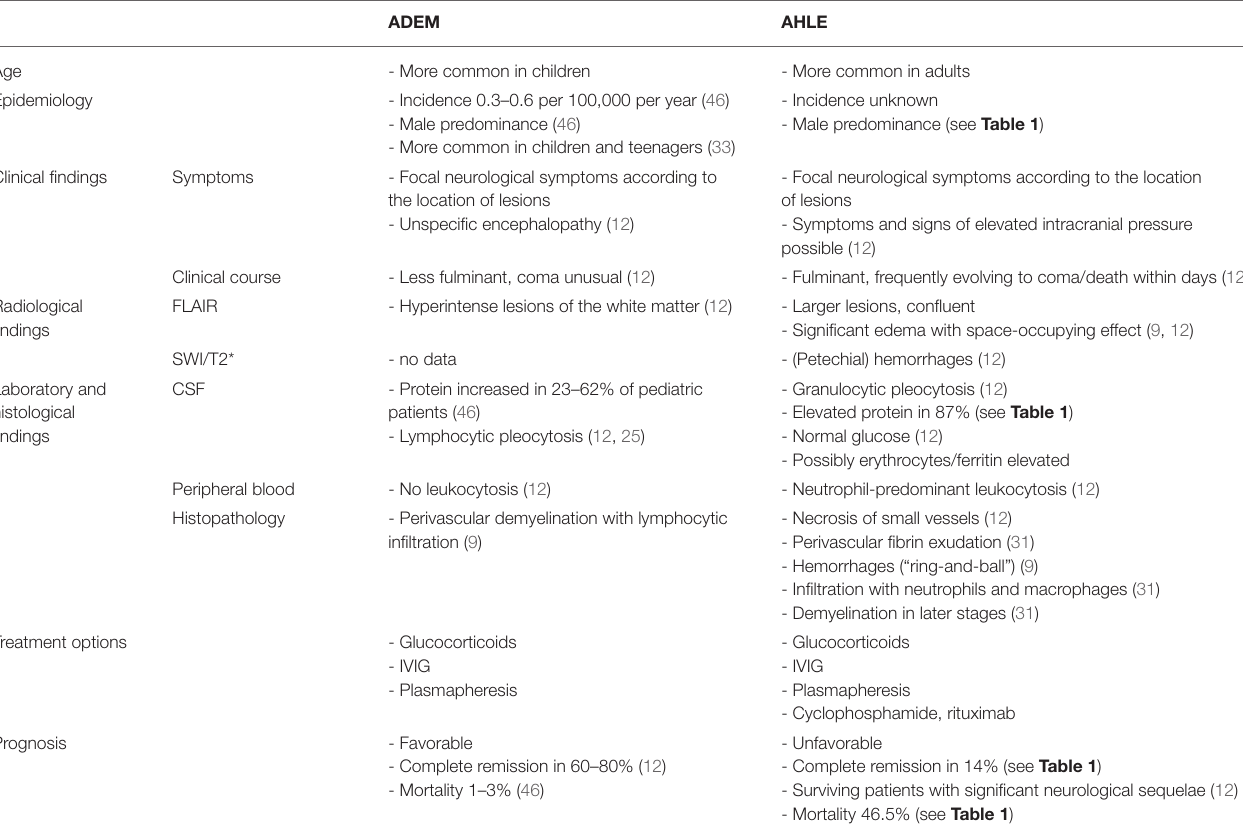
TABLE 2 | Comparison of main clinical, neuroradiologic, and laboratory characteristics between AHLE and